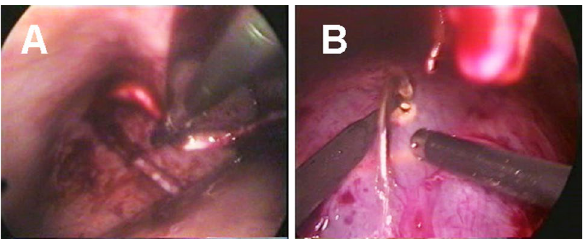
Figure 2. Endoscopic views showing the postoperative complications. ( A ) Obstructive shunt tube in abdominal end; ( B ) cerebrospinal fluid pseudocyst.